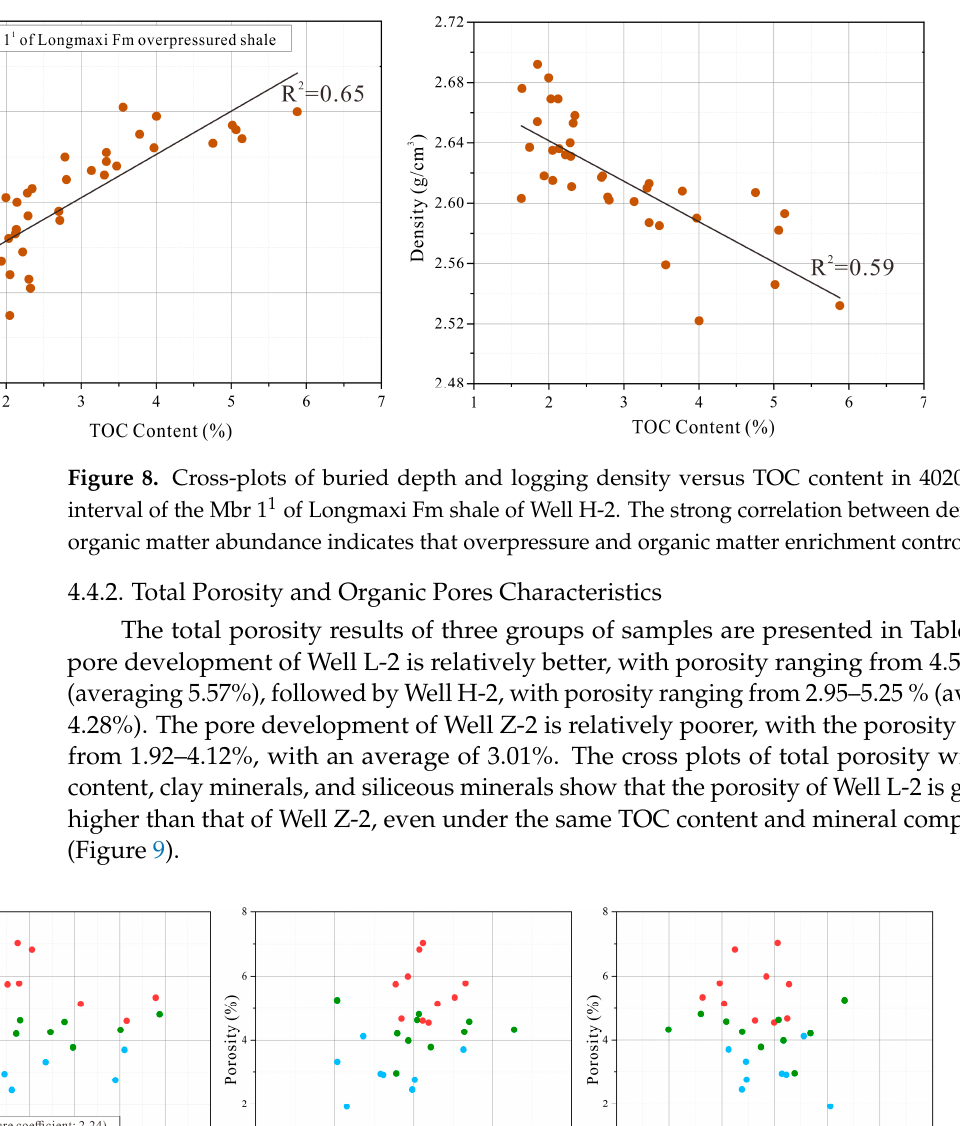
Table 2. Total organic carbon content, mineral composition, and total porosity data of three repre- sentative Mbr 1 1 of Longmaxi Fm shale reservoirs located in the Southern Sichuan Basin.